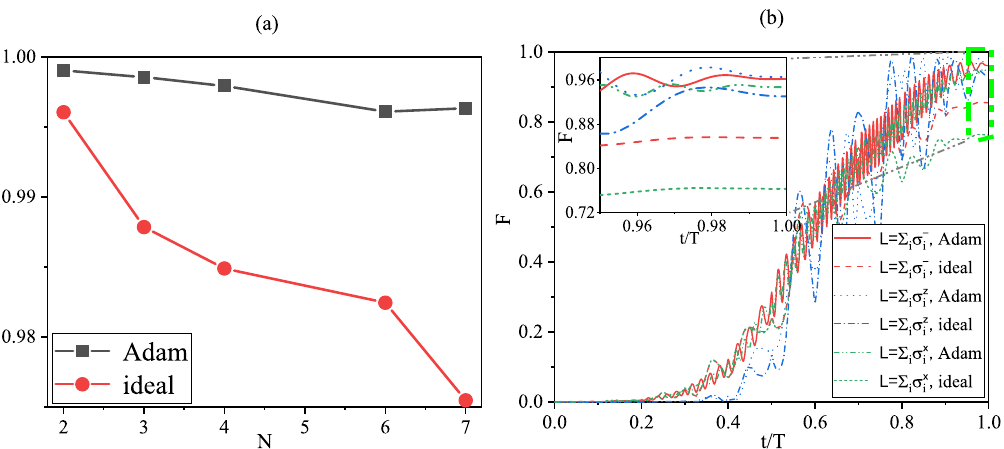
Figure 4. The fidelity improvement Im for different environmental parameters. L = Σ i σ − Tem . For different Γ , γ = 2, Tem = 10. For different Tem , Γ = 0.005, γ = 2. ( b ) γ . Γ = 0.04, Tem = 10.